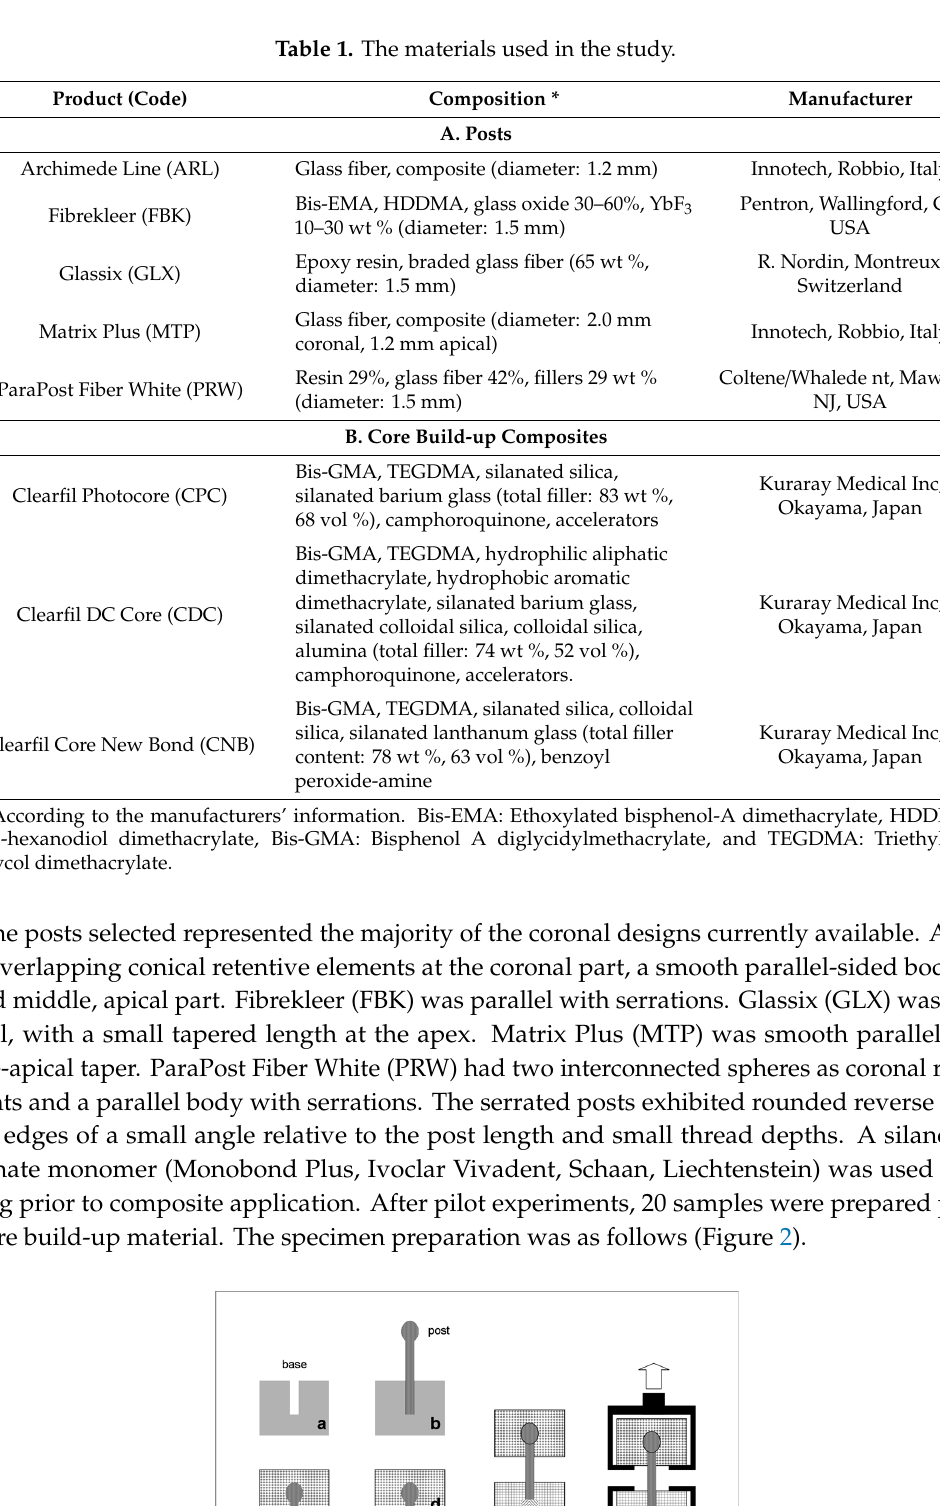
Table 1. The materials used in the study.